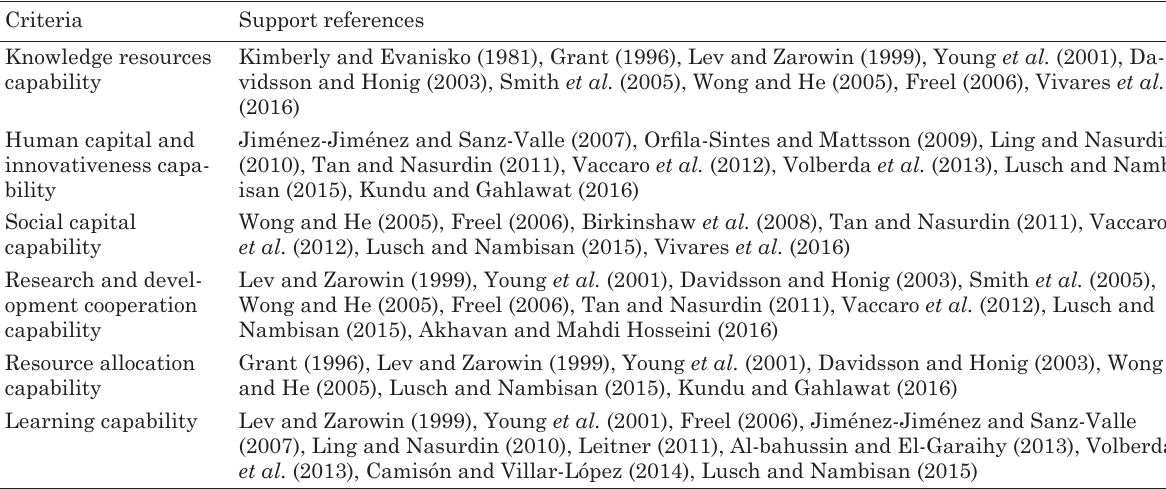
Table 2. Human resources innovation capabilities